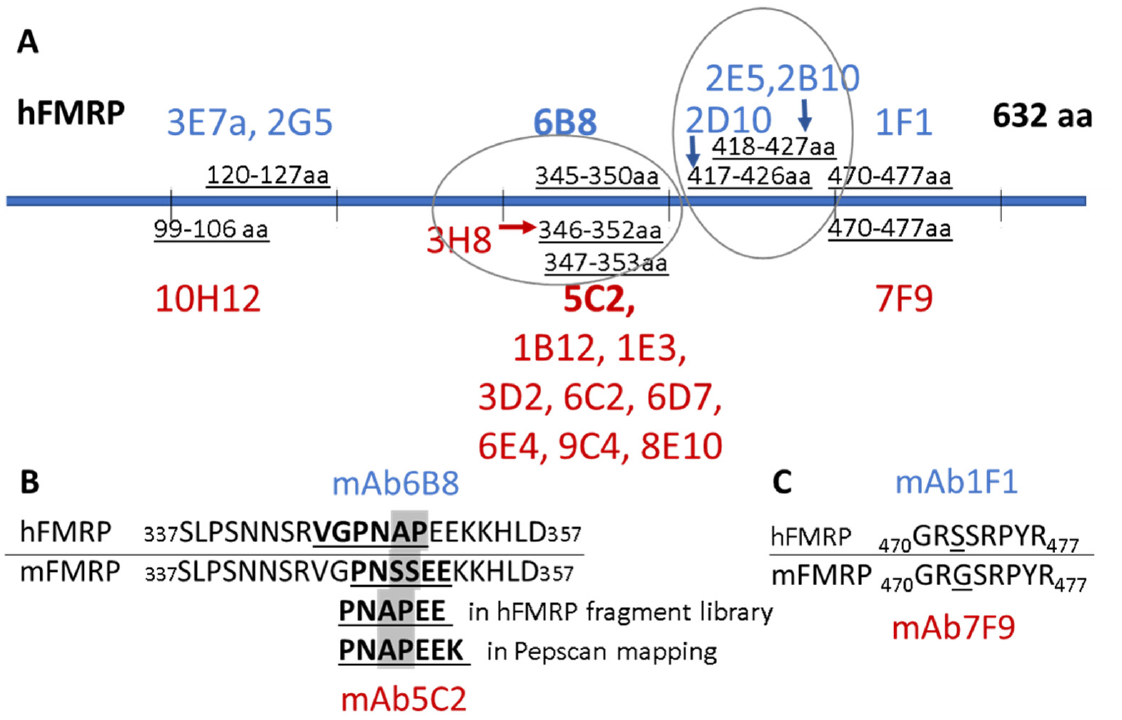
Figure 2. Schematic map of the anti-FMRP mAb epitopes. The epitopes for mAb clones are shown in ( A ) with anti- hFMRP mAbs shown above the schematic view of the protein in blue and anti-mFMRP mAb clones shown below in red. Magnified sequence of super immunogenic region and epitopes of mAb5C2 and mAb6B8 ( B ) and mAb1F1 and mAb7F9 ( C ). The linear epitopes from Pepscan analysis for human FMRP-derived antibodies mAbs 2D10, 2E5, and 2B10 shared the same epitope on exon 13 (with the exception of one residue shift in 2D10 epitope) (Figure 2A). The epitope 417 LDYHLNYLKEV 427 coded by exon 13 is conserved between human and mouse but was clearly favored in antibody pro- duction to human FMRP immunogen. We did not identify an equivalent clone that re- sulted from the mouse immunized with mouse FMRP. The epitope was shared by mAb2G5 and mAb3E7a and the epitope of mAb10H12 coded by exon 5 and conserved between the sequences of mouse and human FMRP. The immunoreactivity of mAB10H12 is shown in Figure S1.C By contrast, the epitope shared by both mAb1F1 and mAb7F9 (exon 14) has one amino acid change between the two species, 470 GR S SRPYR 477 in human, and 470 GR G SRPYR 477 in mouse (Figure 2C). 3.3. Immunoassay for Quantification of Mouse FMRP Our laboratory previously developed a Luminex-based capture immunoassay, qFMRP, that accurately quantifies FMRP using the human-specific mAb6B8 (available through Biolegend, San Diego, CA, USA) capturing antibody [28]. The mAb5C2 (available through Biolegend, San Diego, CA, USA) has high avidity for mouse FMRP and was suc- cessfully used for immunohistochemical characterization of FMRP expression in neurons and glia in mice [38,39]. We selected this antibody to establish a parallel Luminex-based immunoassay (qFMRPm) for quantification of FMRP in mouse-derived tissue samples. In the assay, we used mAb5C2-coupled microspheres to capture FMRP, which was followed by detection with the anti-FMRP rabbit antibody R477. First, we evaluated the capacity and specificity of the 5C2-R477 antibody pair to capture and detect endogenous FMRP in the immunoassay of whole brain homogenates from wild type (WT) and Fmr1 knockout (KO) mice. We used 2.5 to 160 µg of the total protein. The amount of FMRP detected in